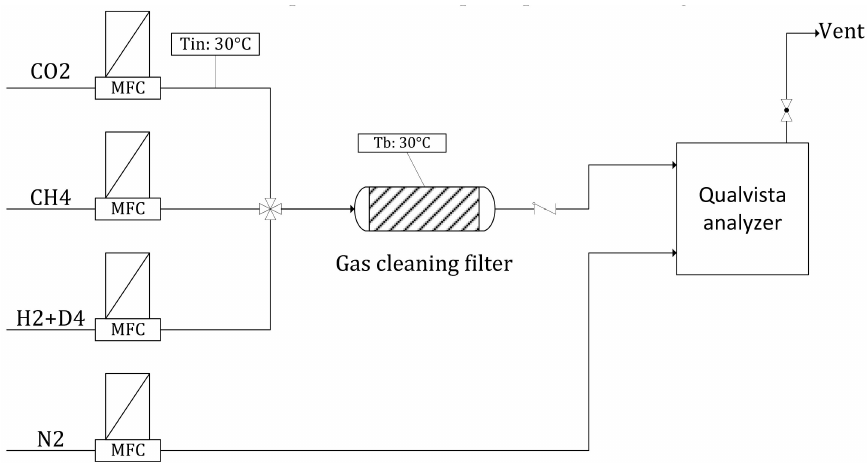
Figure 1. Experimental set-up for siloxane isotherm